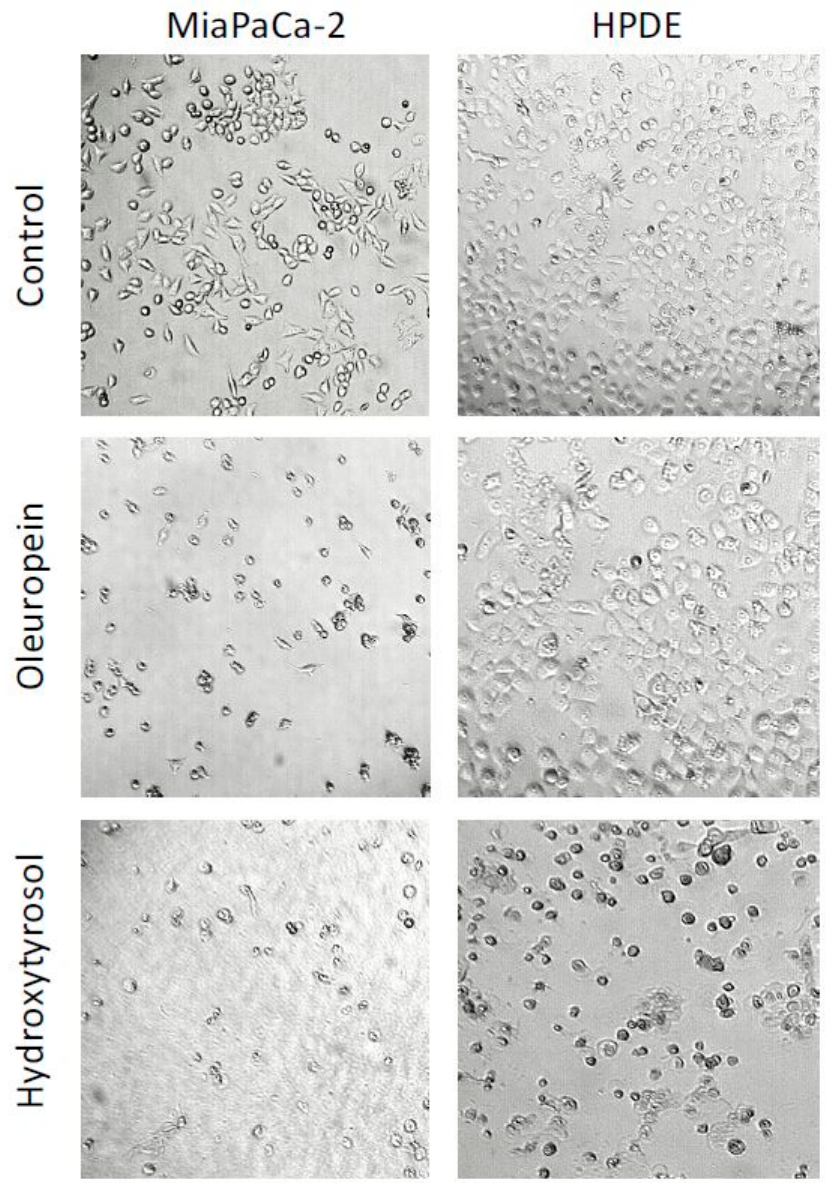
Figure 2. Morphological changes of MIA PaCa-2 and HPDE cells when treated with oleuropein and hydroxytyrosol for 24 h at ×100 magnification. hydroxytyrosol for 24 h at × 100